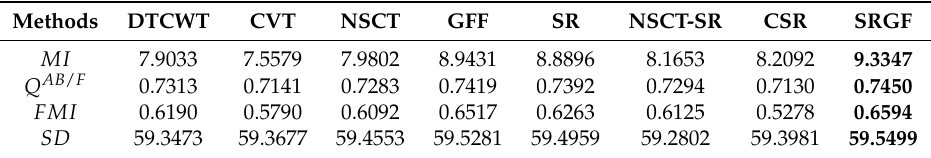
Figure 9. Fusion of “face” images. DTCWT, dual-tree complex wavelet transform; CVT, curvelet transform; NSCT, nonsubsampled contourlet transform; SR, sparse representation. Table 1. Quantitative assessments of “face”